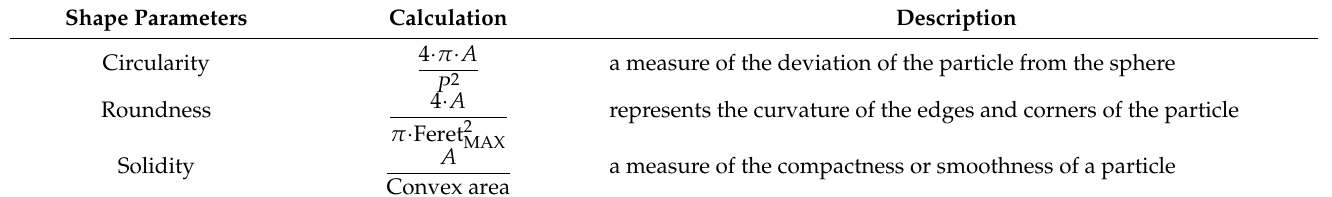
Table 1. Measured shape parameters, their calculation equations, and the description of each parameter. Shape Parameters Calculation Description · π · A Circularity 4 Roundness Solidity A Convex